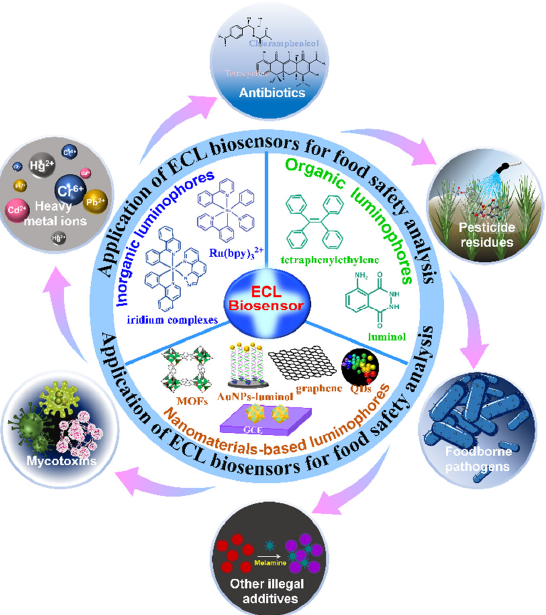
Figure 1. Scheme of the principles of ECL biosensors, ECL luminophores, and their ECL applications in food analysis. in food